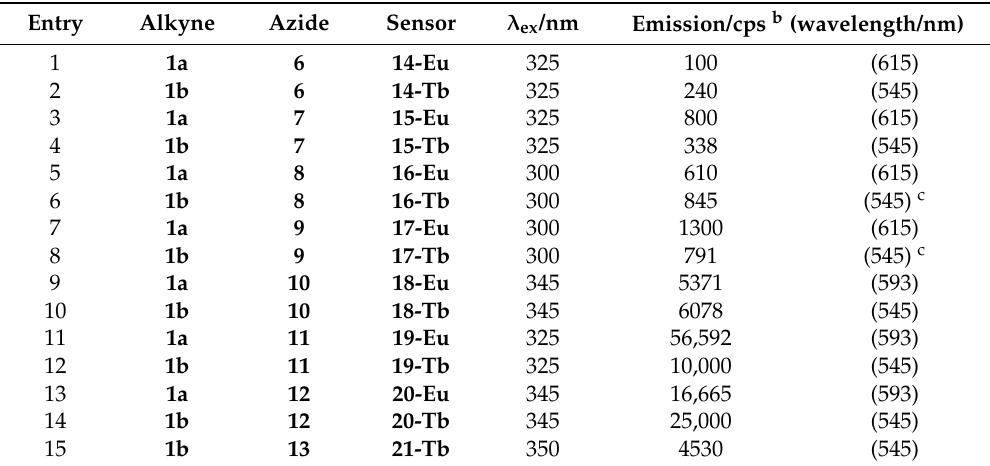
Table 1. Sensor Output after CuAAC Reaction a